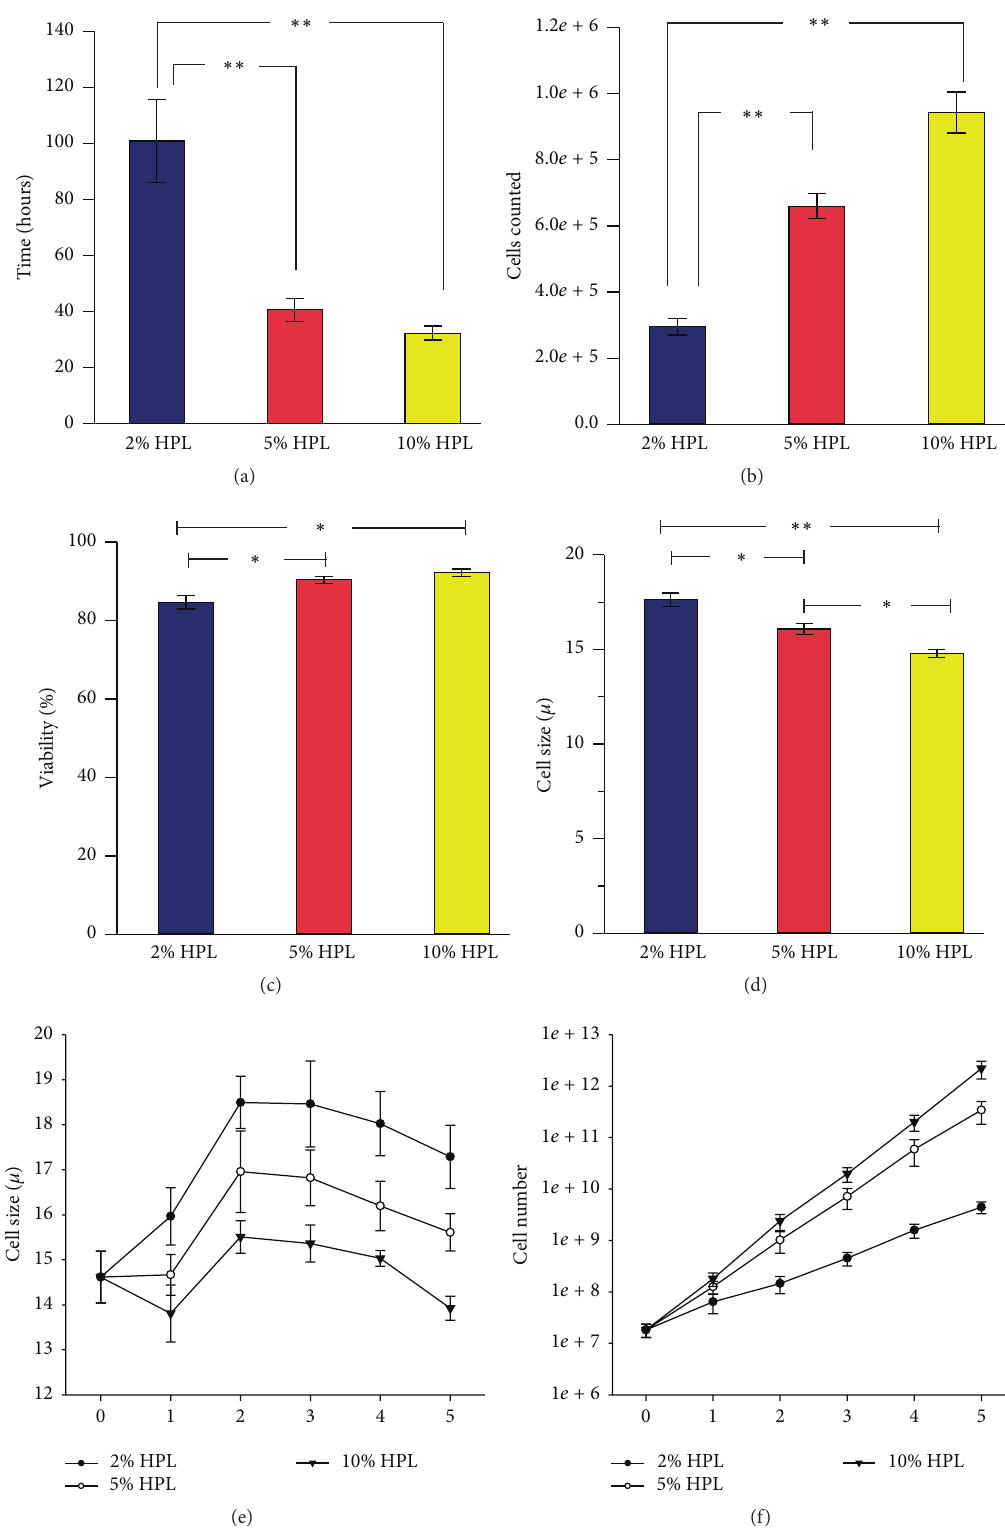
Figure 3: Effect of HPL concentration on expansion. (a–d) UC-MSC ( 𝑛 = 6 ) expansion results combined for passages 1–5. (a) Population doubling times for the 3 media conditions. (b) Number of cells counted at passage for each media condition. (c) Cell viability at passage for each media condition. (d) The average size of the cell for each media condition at passage. (e) Cell size over 5 passages for each media condition. (f) The theoretical yield if an entire umbilical cord was isolated and grown to confluence at each passage. ∗ means 𝑝 < 0.05 and ∗∗ means 𝑝 < 0.001